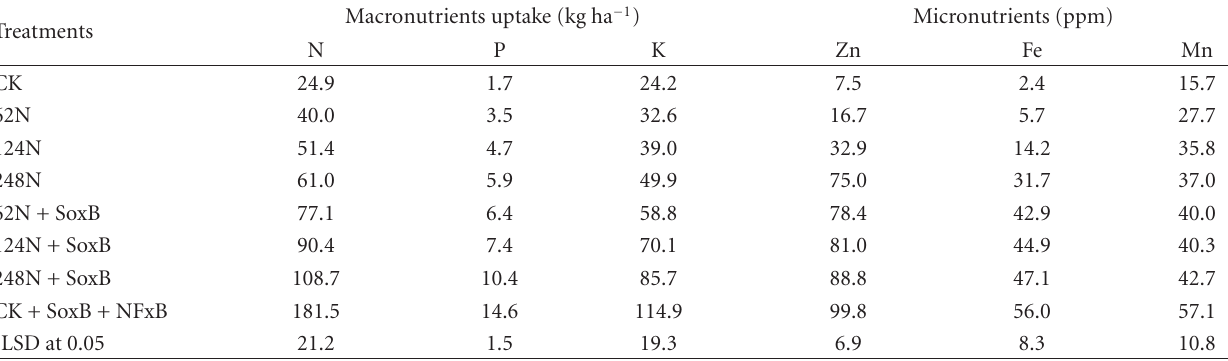
Table 2: E ff ect of nitrogen and soil inoculation with sulfur-oxidizing (SoxB) and nitrogen-fixing bacteria (NFxB) on nutrient uptake by onion plants.